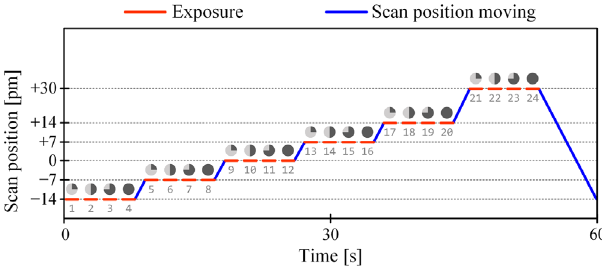
Fig. 3. Acquisition sequence followed by PMI. Numbers below red dashes correspond to image number in the sequence. Quarter circle, half circle, three quarter circle and full circle symbols correspond to four de fi ned modulations of the polarisation state. Scan position is given with respect to the line